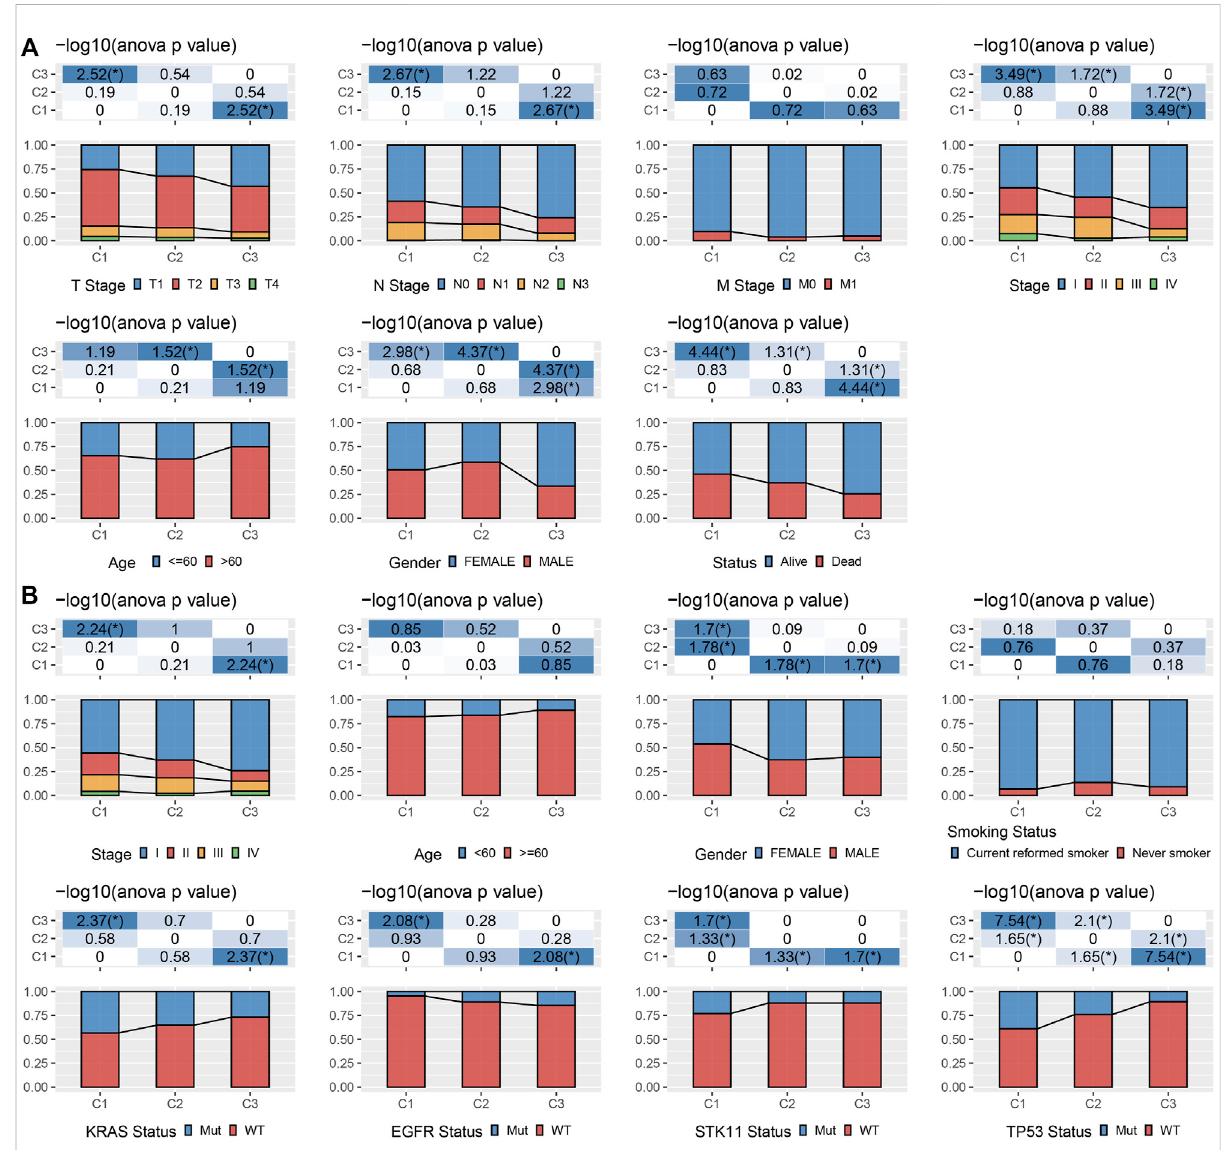
FIGURE 2 Clinicopathologicalpropertiesofmolecularsubtypes. (A) TheclinicopathologicalcharacteristicsofmolecularsubtypesinTCGAcohort; (B) The clinicopathological characteristics of molecular subtypes of GSE72094 cohort; The lower and upper parts of the proportion are the statistical signi fi cance of the distribution difference in two pairs -log10 ( p